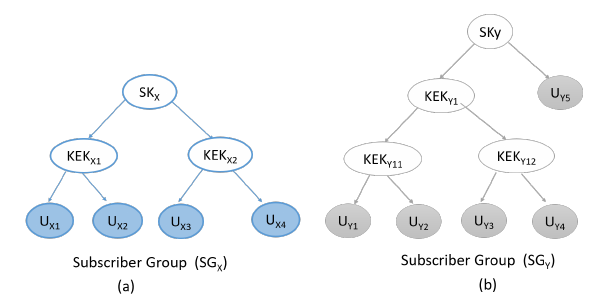
Figure 8. The figure shows the inner LKH trees of the groups SG X and SG Y before merging.